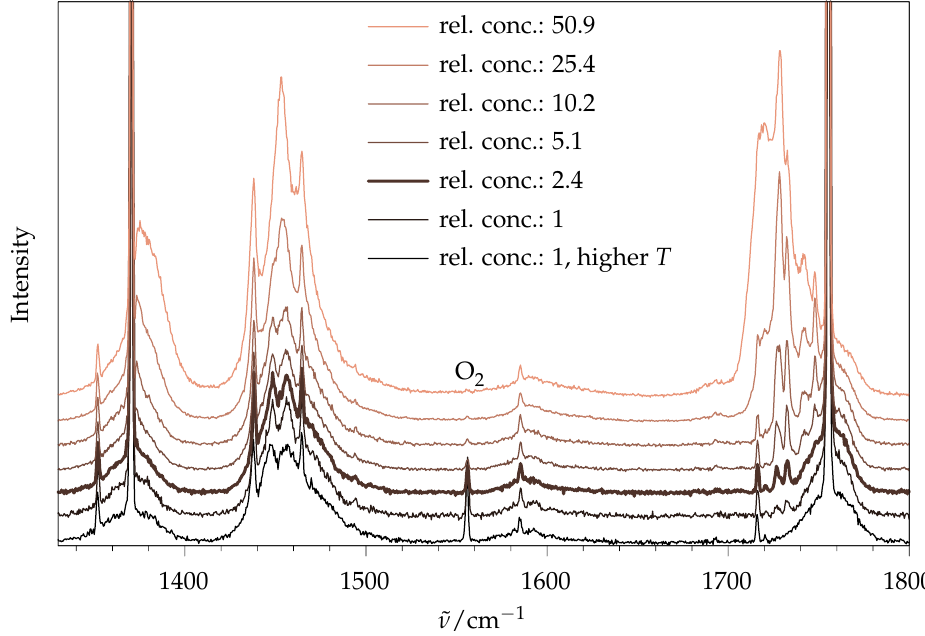
Figure 3. Raman jet spectra of methyl methanoate for widely different ester concentrations, scaled to the peak monomer signal at 1755cm − 1 . The expansion conditions are identical, except for the lowest trace, where a reduced distance to the nozzle (0.5mm) leads to higher temperature. The O 2 signal is due to air impurity. The relative concentration of 2.4 was chosen for further analysis (bold trace).